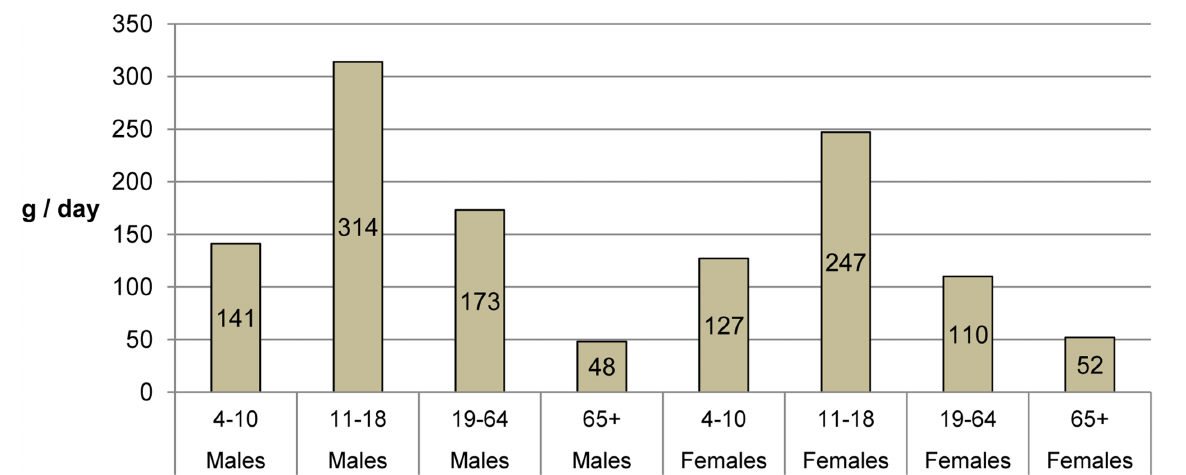
Fig 3. Average grams per day consumed of soft drinks by age group and gender (includes non-consumers of soft drinks). Data for England from NDNS, 2008 – 10 [20].